Question: How would you classify this visualization?
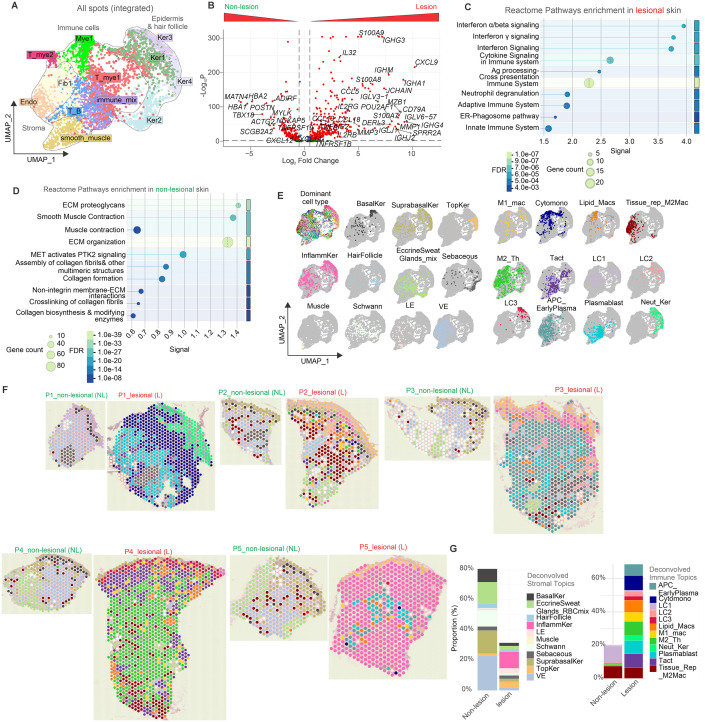
Answer: scatter